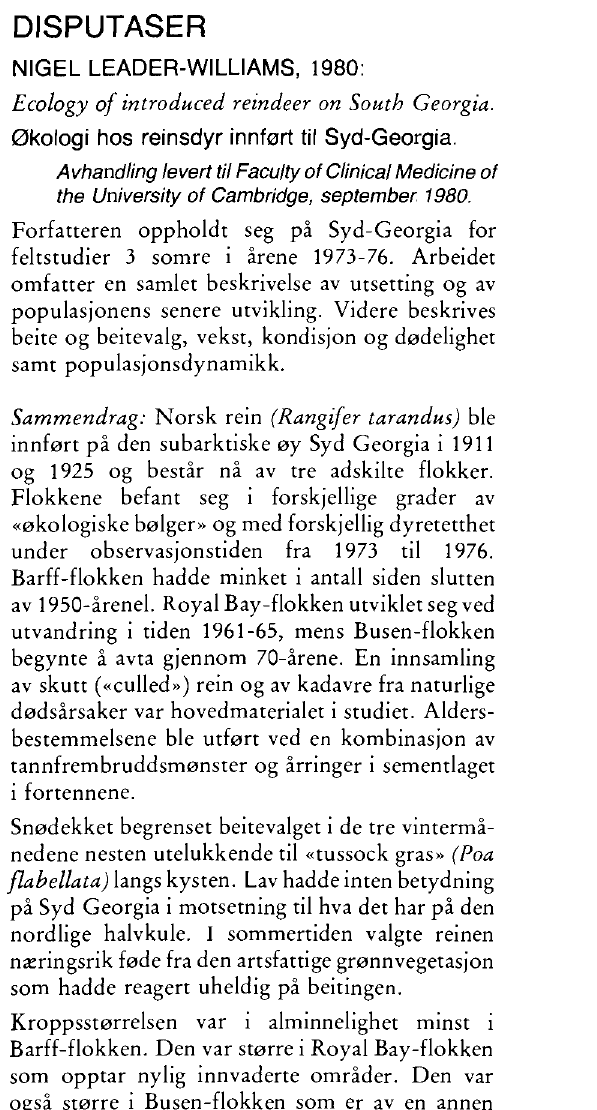
Fig. 1. Linguatula serrata from